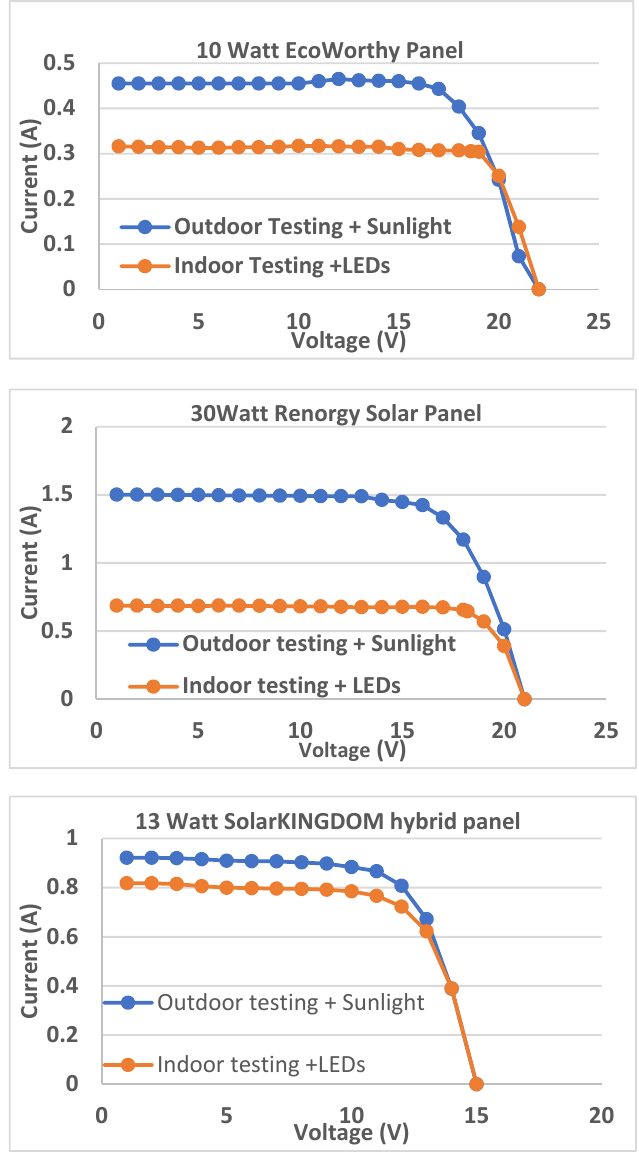
Figure 10. Testing the power output of the three solar panels used; outdoor with sunlight versus artificial light